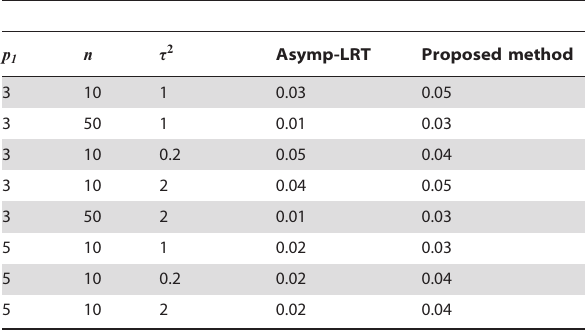
Table 1. Type I errors for homoscedastic normally distributed